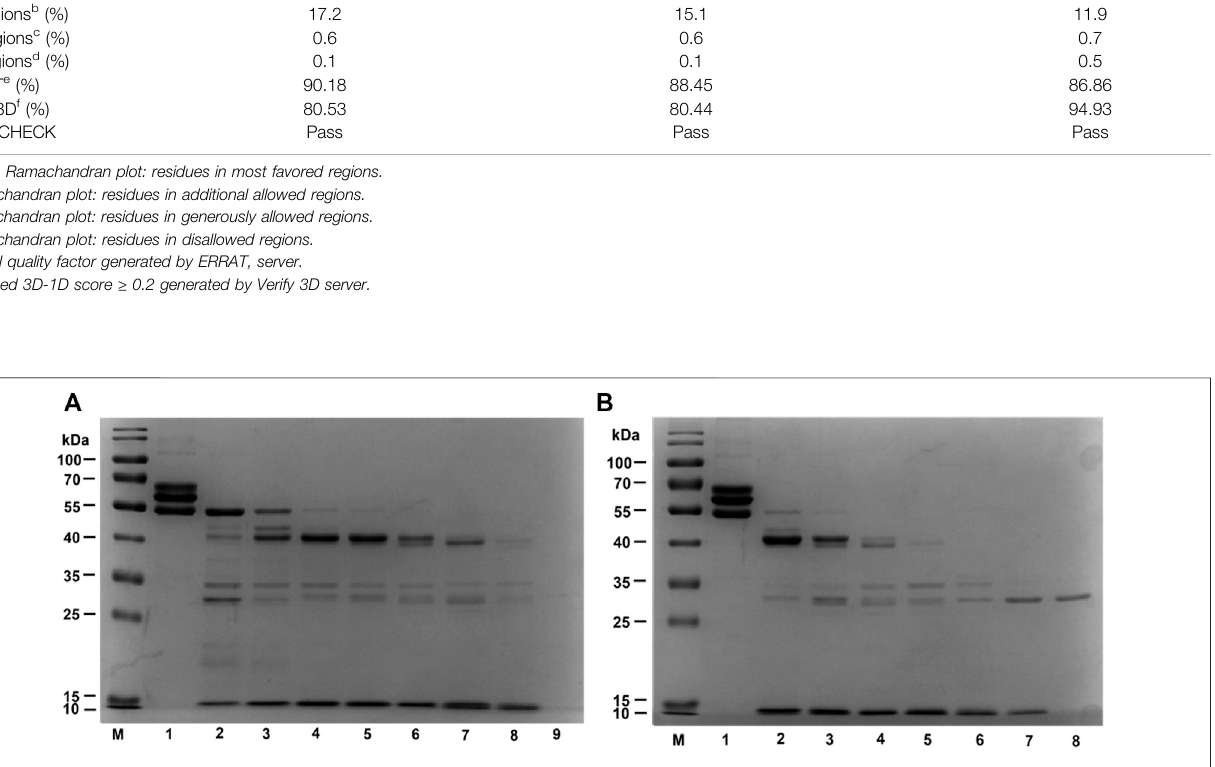
FIGURE 9 | Fibrinogen hydrolysis by EPF3 in a time-dependent manner (A) and dose-dependent manner (B) . (A) Lane 1: fi brinogen; Lane 9: EPF3; Lanes 2 to 8: aliquots were taken at 5, 10, 20, 30, 60, 120, and 240 min, respectively. (B) Lane 1: fi brinogen; Lane 8: EPF3; Lanes 2 to 7: different concentrations of EPF3 (5, 10, 20,